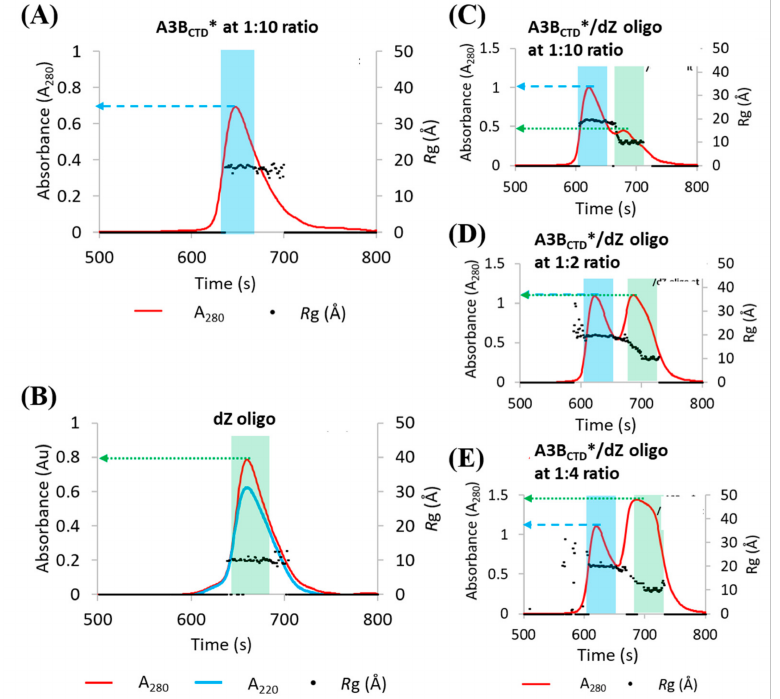
Figure 2. SEC elution profiles of A3B CTD * in varying molar ratios with dZ-oligonucleotide. SEC elution profiles of ( A ) A3B CTD * at 5.0 mg/mL (~230 µ M). ( B ) dZ-oligo at 0.68 mg/mL (~230 µ M). ( C ) A3BCTD* with dZ-oligo at a 1:1 ratio. ( D ) A3B CTD * with dZ-oligo at a 1:2 ratio. ( E ) A3BCTD* with dZ-oligo at a 1:4 ratio. Samples were run at 25 ◦ C through a SEC column at a flow rate of 0.2 mL/min in the buffer containing 50 mM citrate-phosphate (pH 5.5), 0.2 M NaCl, 2 mM β -ME. Blue bar region and arrow represent A3B CTD * elution, green bar region and arrow represents dZ-oligo elution. Ratio represents molar ratio of protein mixed with